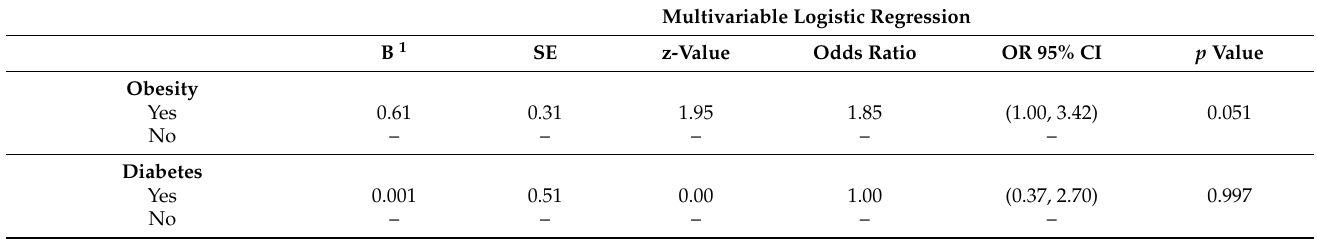
Table 6. Multivariable logistic regression for truncal swelling ( N =